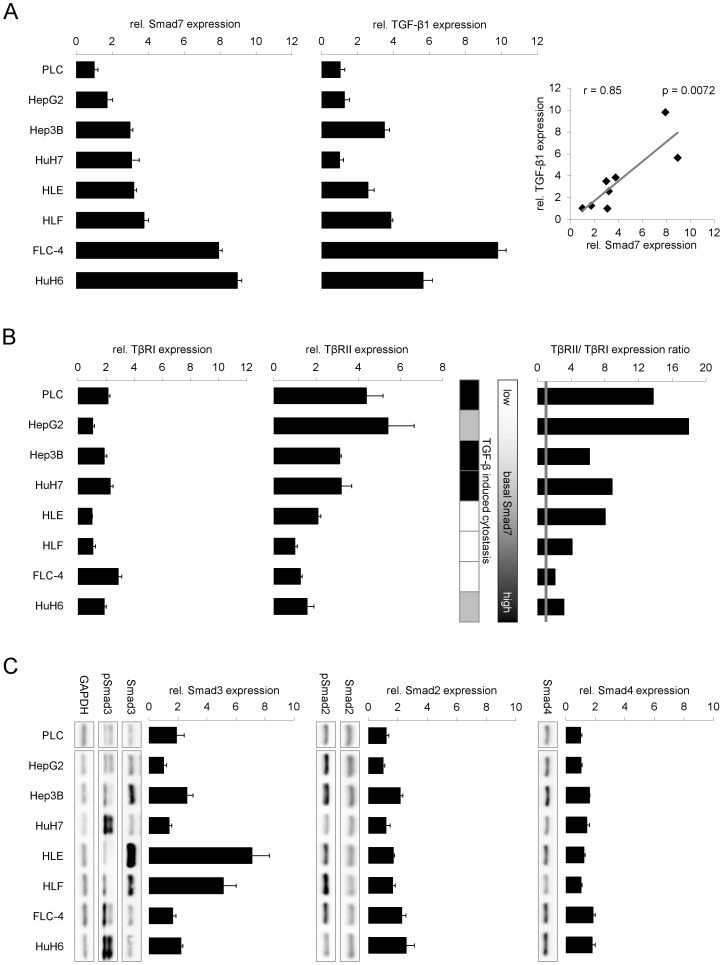
Expression levels of TGF-β/Smad signaling components in HCC cell lines.Relative TGF-β1 and Smad7 (A), TGF-β receptor I (TβRI) and II (TβRII) (B) and Smad2, Smad3, and Smad4 (C) expression levels were detected using real time PCR. Expression of 18s rRNA was used as reference and results were analyzed with the ΔΔCt method. A strong correlation of Smad7 and TGF-β1 expression was identified by calculating the Pearson coefficient (r  =  0.87; p  =  0.0011) (A). Further, TβRII expression (filled bars) was generally increased compared to the expression of TβRI (grey line) in the same cell line (B, right). Additionally, total and phosphorylated Smad2 and Smad3 as well as basal Smad4 protein levels were evaluated by Western Blot using GAPDH as loading control (C).